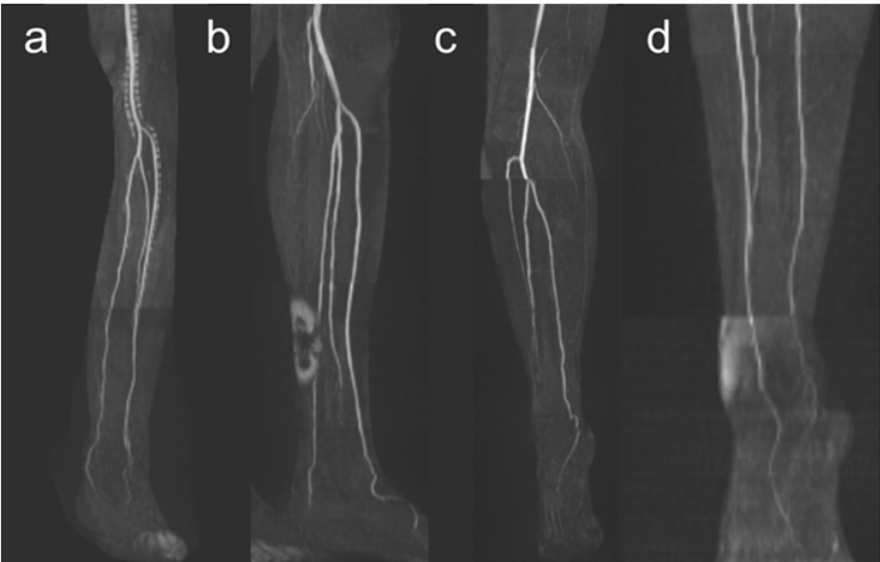
Figure 1. Imaging artifacts. Venous contamination is shown in panel ( a ), signal dropouts due to endoprostheses or other metallic implants in panel ( b ), stair ‐ step artifacts in panel ( c ), and different signal intensities within a measurement slab in panel ( d ). Motion artifacts are not demonstrated here because they can only be traced in the course of several transverse slices.